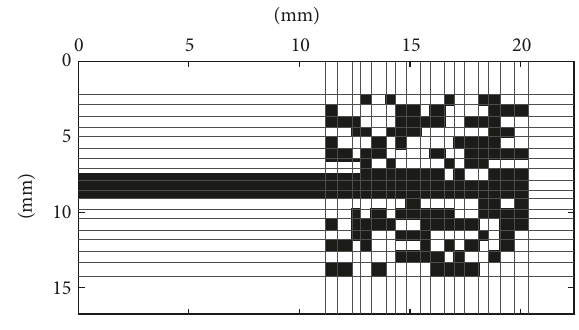
Figure 9: Patch antenna configuration in the evolutionary